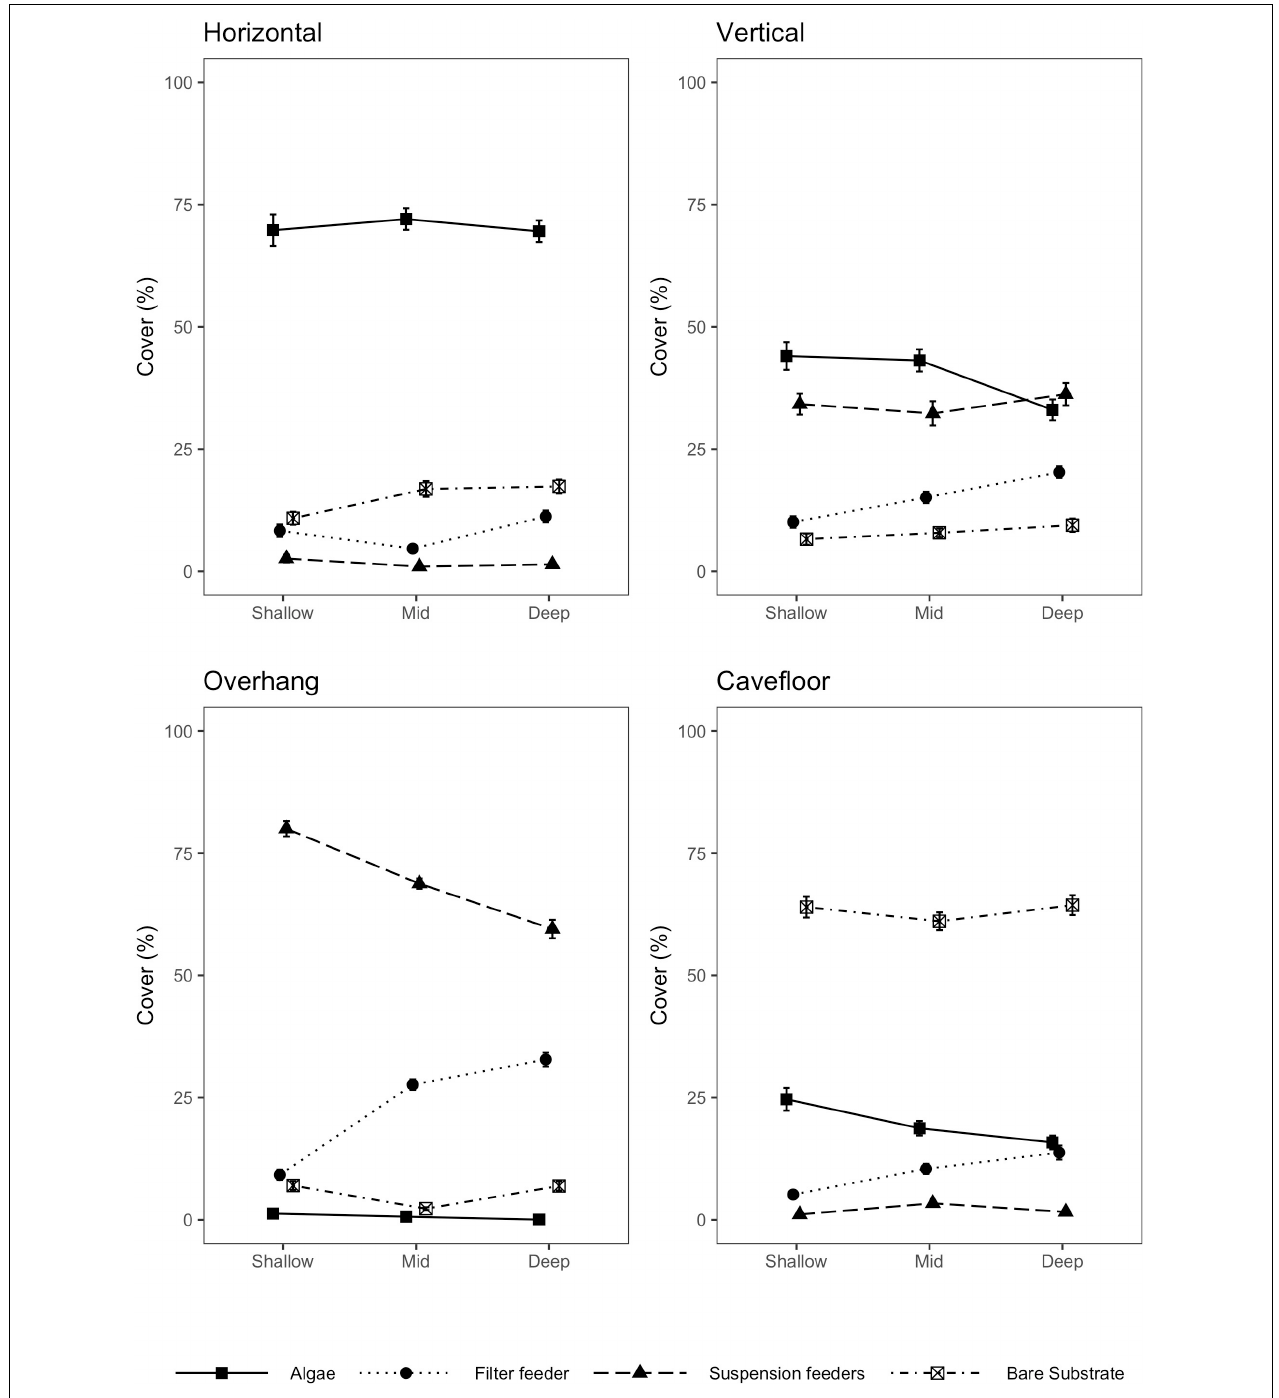
FIGURE 3 | Percentage cover ± SE, of algae, bare substrate, filter feeders and suspension feeders on each orientation surface for shallow ( n = 40), mid ( n = 60), and deep reefs ( n = 40).